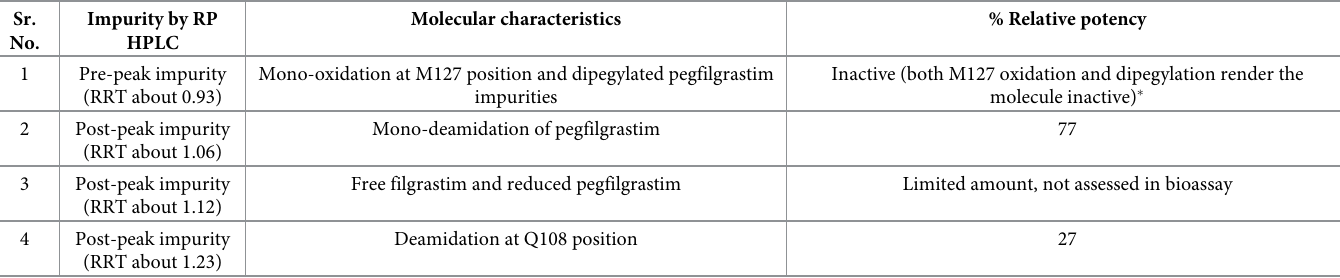
Table 6. Summary of characterization of peaks observed by RP-HPLC. Sr. No.